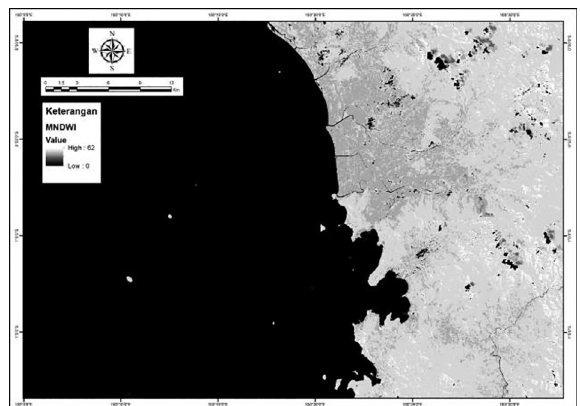
Figure 4. MNDWI transformation Figure 5. DSAS processing